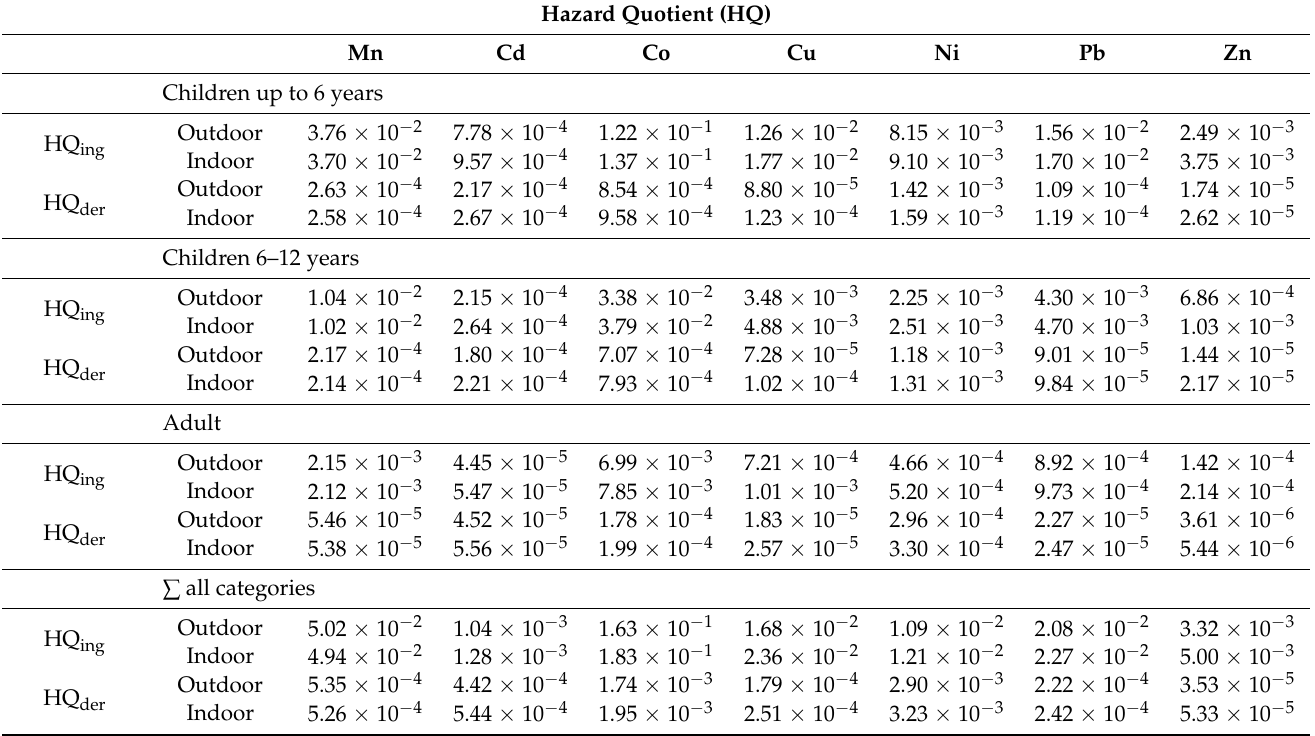
Table 3. Average of hazard quotient (HQ) for pathways exposure and for all categories of human for outdoor and indoor dust samples in elementary school environment.